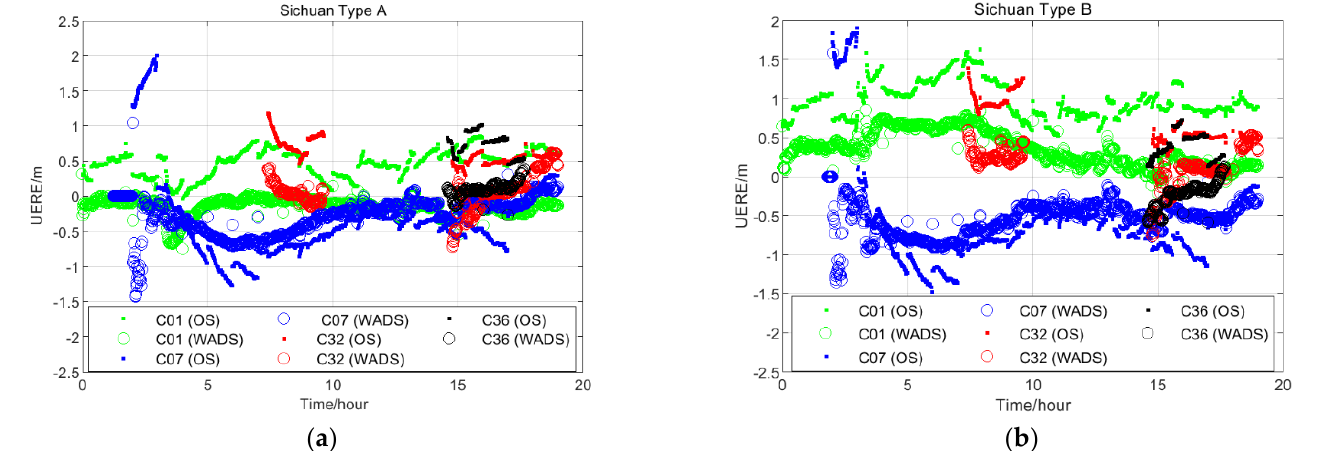
Figure 4. The UEREs calculated by a type A receiver and a type B receiver in the OS and the WADS: ( a ) the results of the type A receiver; ( b ) the results of the type B receiver.